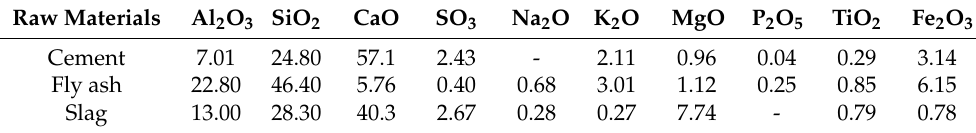
Table 1. Chemical composition of raw materials